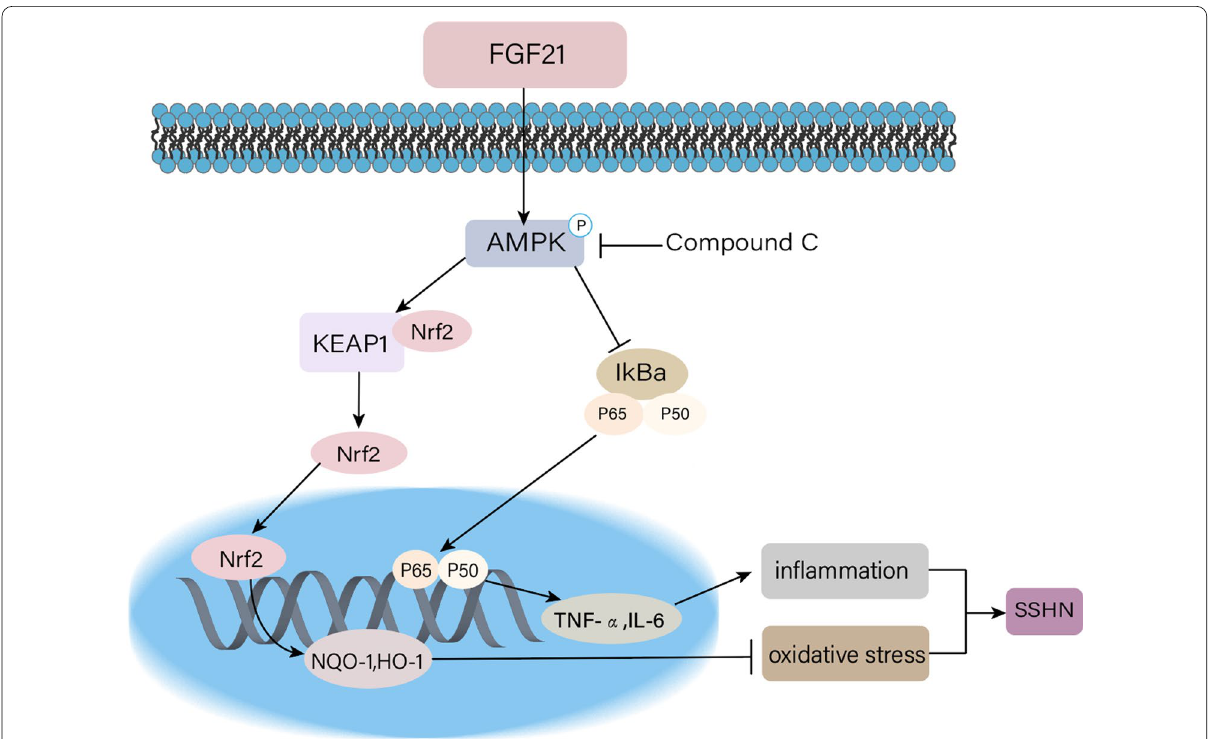
Fig. 8 Mechanistic illustration of the basis of FGF21 protection against SSHN. FGF21 inhibits renal inflammation and oxidative stress by promoting AMPK phosphorylation via Nrf2‑mediated antioxidant effects and inhibition of NF‑κB‑related inflammation, resulting in protection against DOCA‑salt‑induced SSHN in